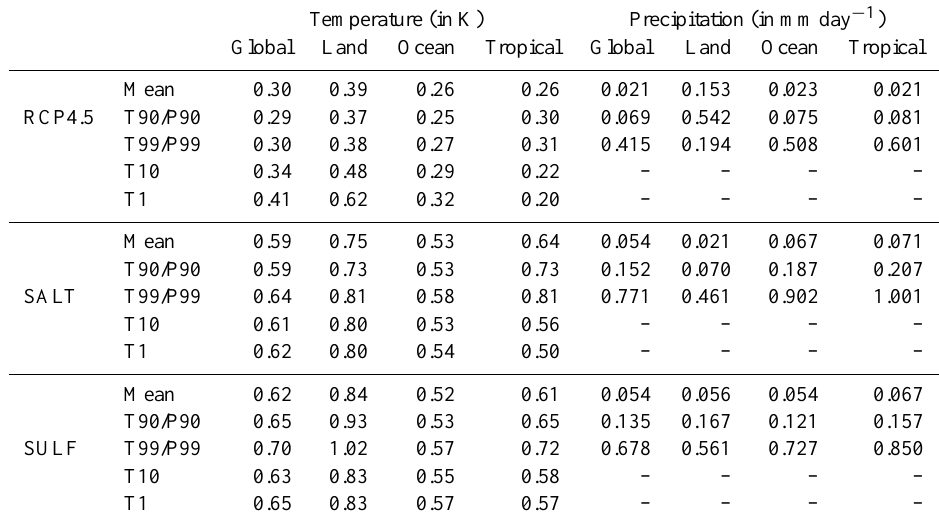
Table 5. Change in temperature and precipitation for the 2070–2089 period with respect to the 2050–2069 period.